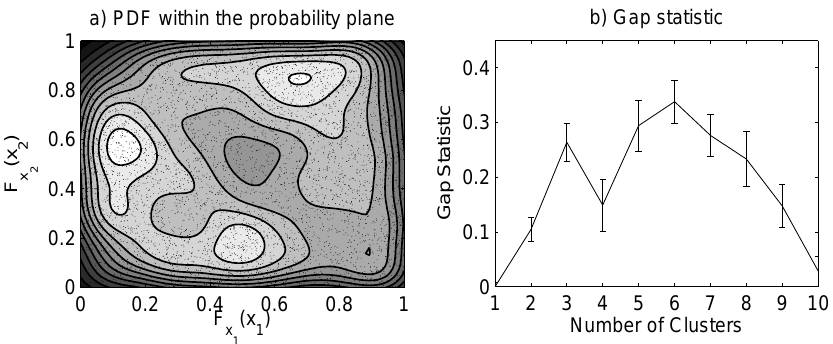
Fig. 8. Scatterplot of the leading two Isomap times series within the probability plane (a) and the associated clustering L-curve (b). The shading in (b) represents the upper and lower envelopes of clustering indexes obtained from 100 simulatedhomogeneous Poissonpoint process.